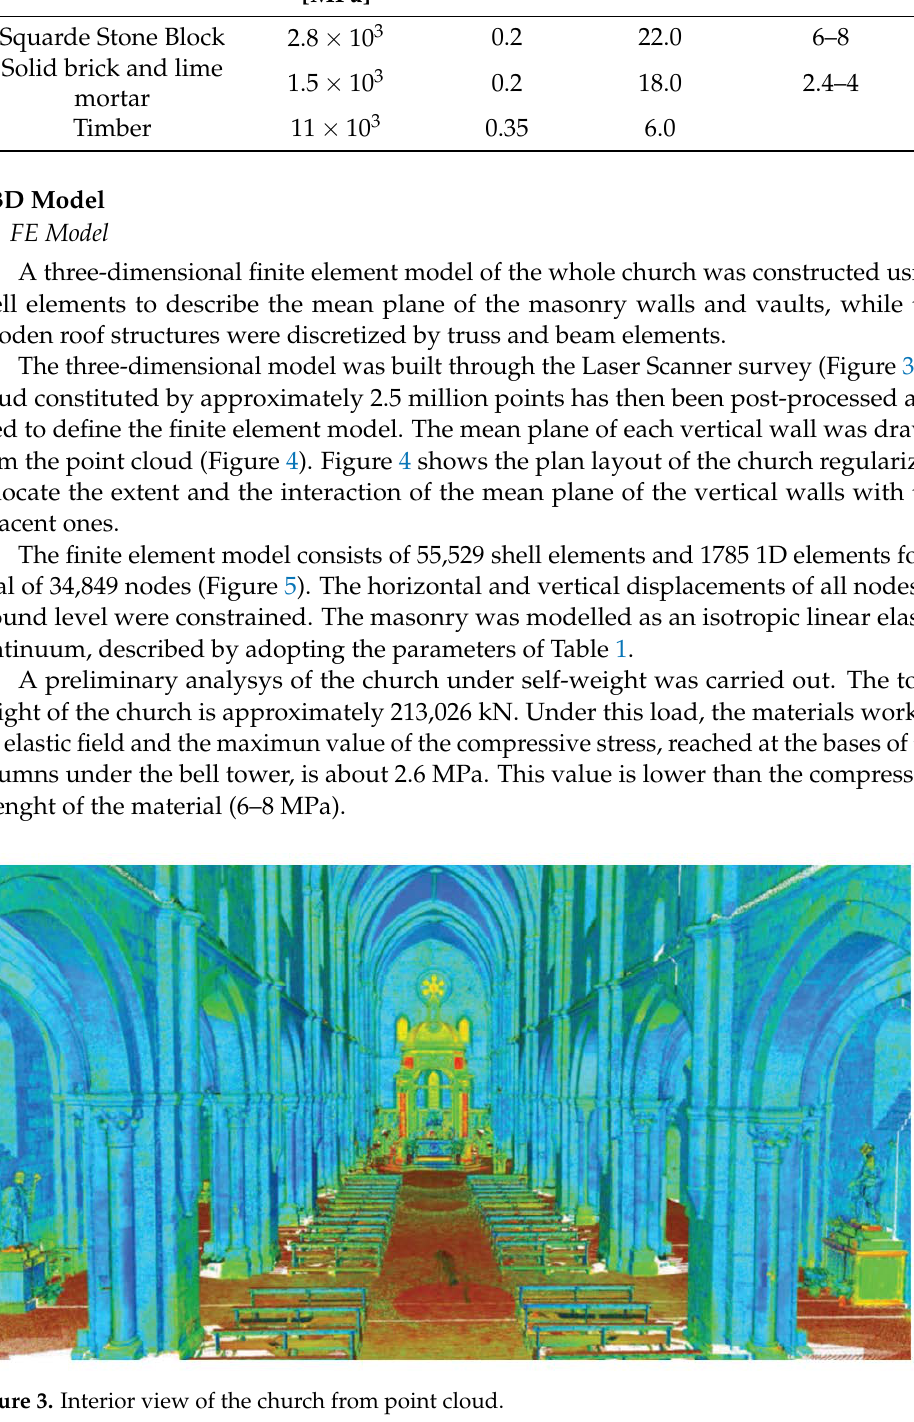
Figure 3. Interior view of the church from point